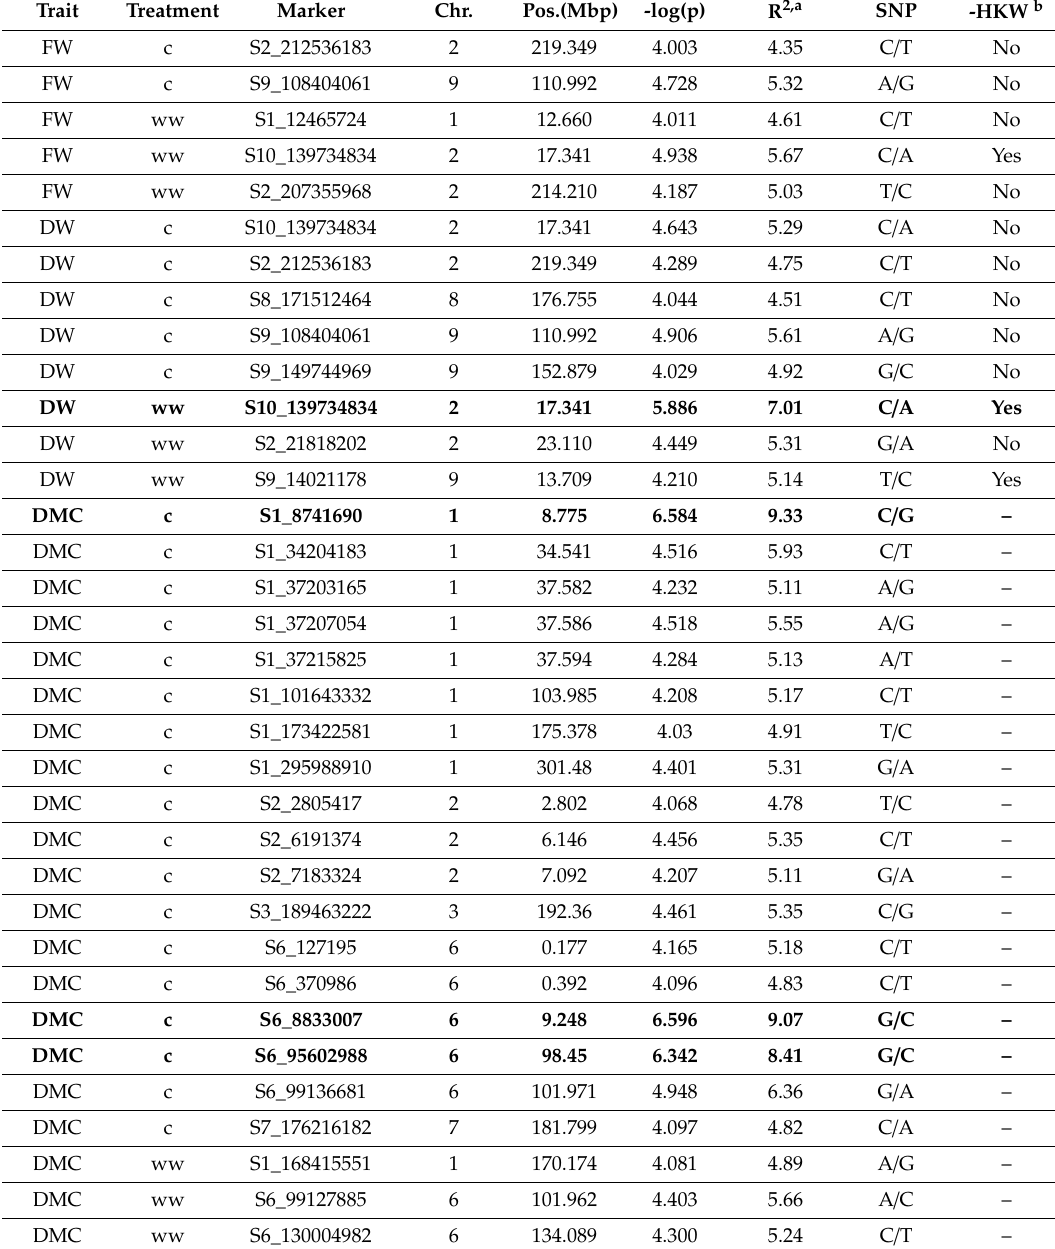
Table 3. SNPs crossing arbitrary threshold of 4 associated with biomass traits fresh weight in grams (FW), dry weight in milligrams (DW), and dry matter content as % of FW (DMC) in control (C) and water withholding (WW) treatments. In bold are the SNPs crossing Bonferroni corrected threshold value for significance at α = 0.05. Shown are the results for MLM + Q + K + HKW analysis for DW and FW and MLM + Q + K for DMC. Results of MLM + Q + K without HKW for FW and DW are available as Supplementary Table